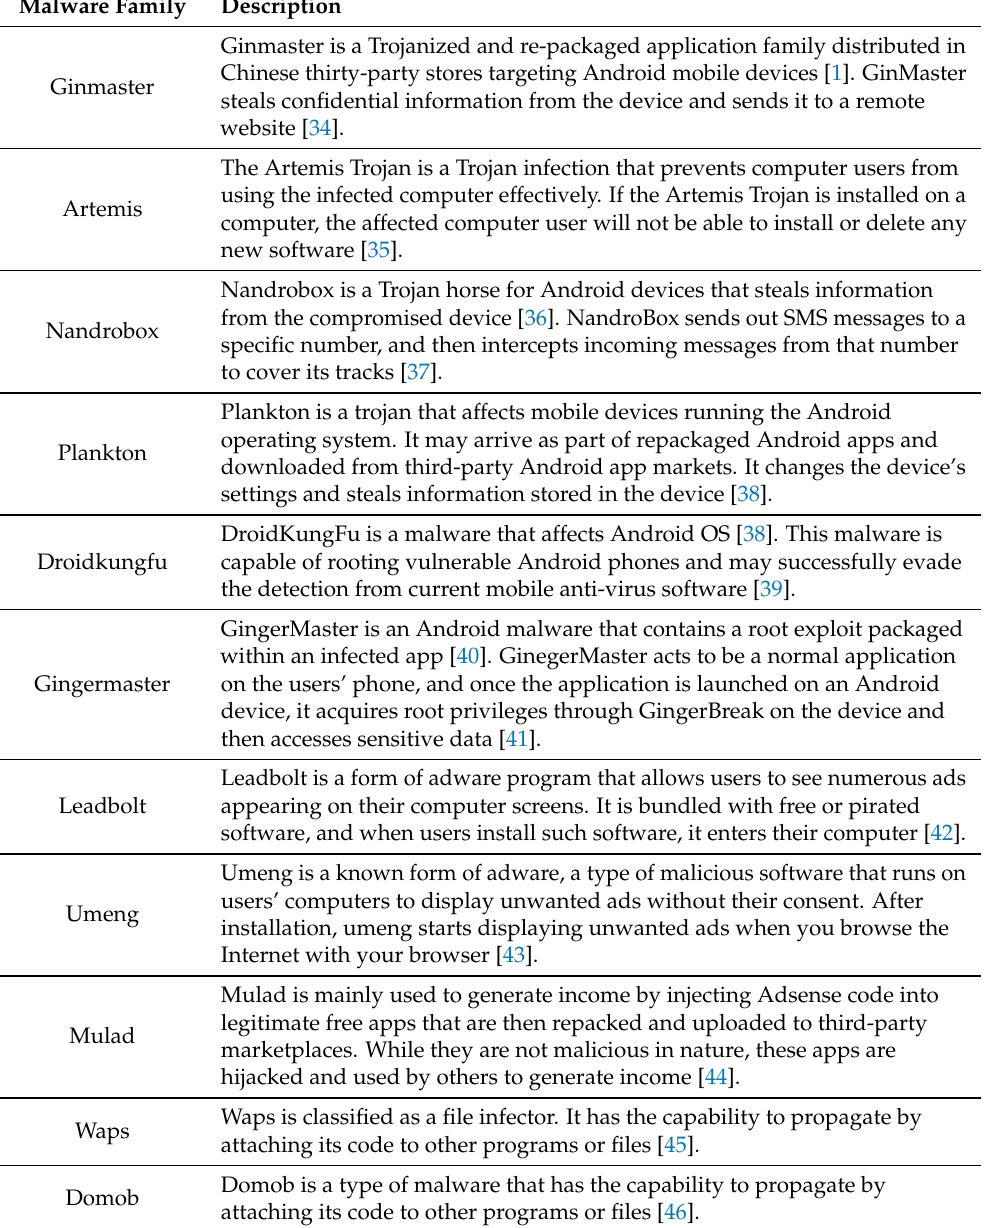
Table 2. The detailed description of the selected malware